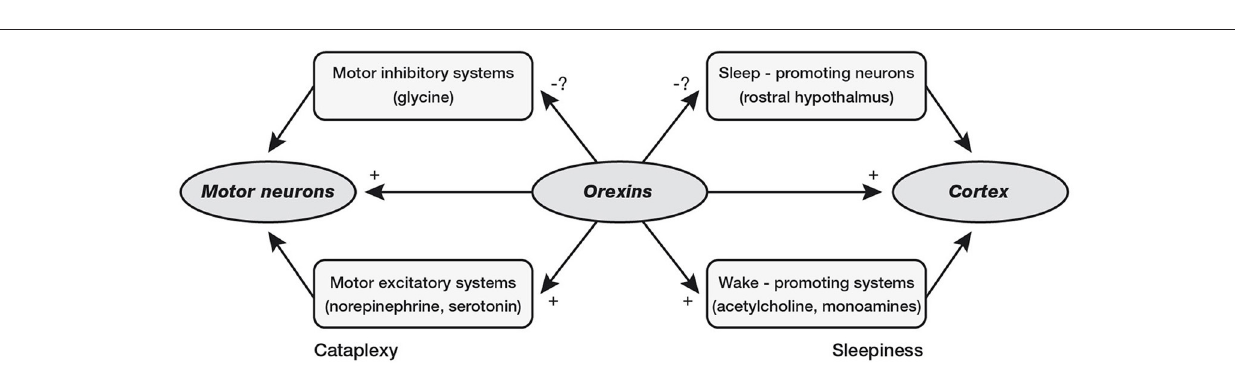
between sleep and cognition (Esposito and Carotenuto,